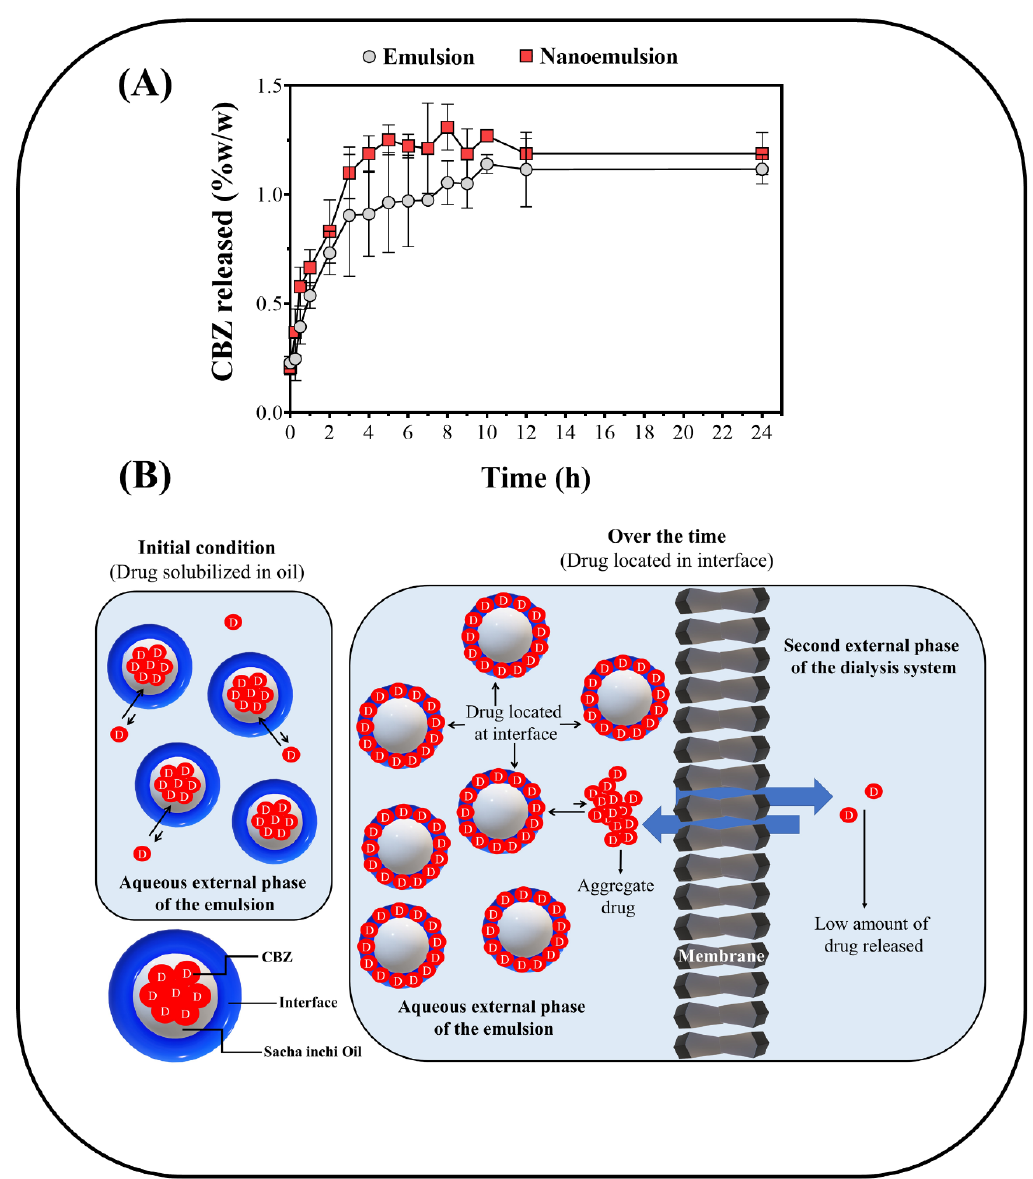
Figure 4. ( A ) In vitro CBZ release for emulsion and nanoemulsion formulations. ( B ) Scheme of CBZ Figure 4. (A) In vitro CBZ release for emulsion and nanoemulsion formulations. (B) Scheme of CBZ migration from the oily phase to the interfacial zone, a ff ecting the drug’s migration from the oily phase to the interfacial zone, affecting the drug’s permeability.